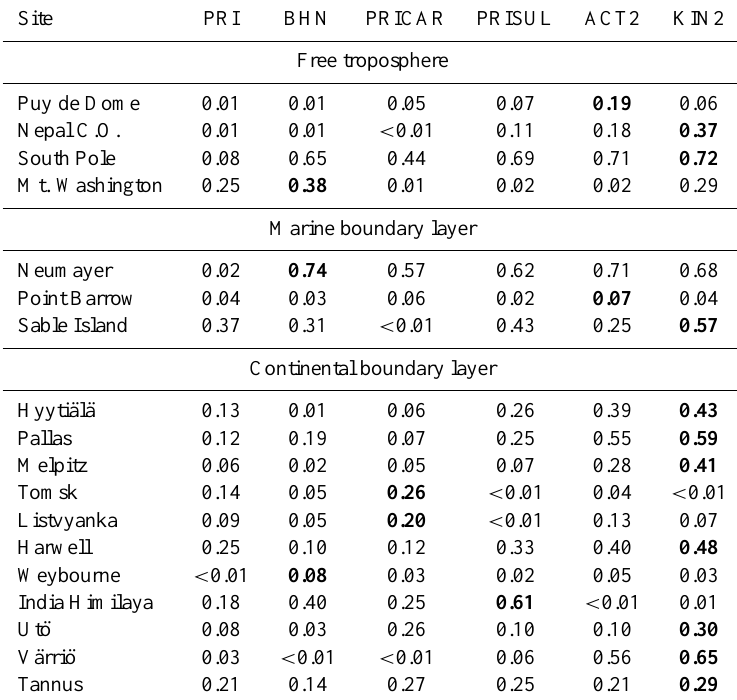
Table 4. Correlation coefficient ( R 2 ) between observed and simulated monthly mean CN concentrations at sites where monthly mean concentrations vary by more than a factor of two throughout a seasonal cycle. Model experiments are described in Table 1. The model run with the best correlation at each site is highlighted.